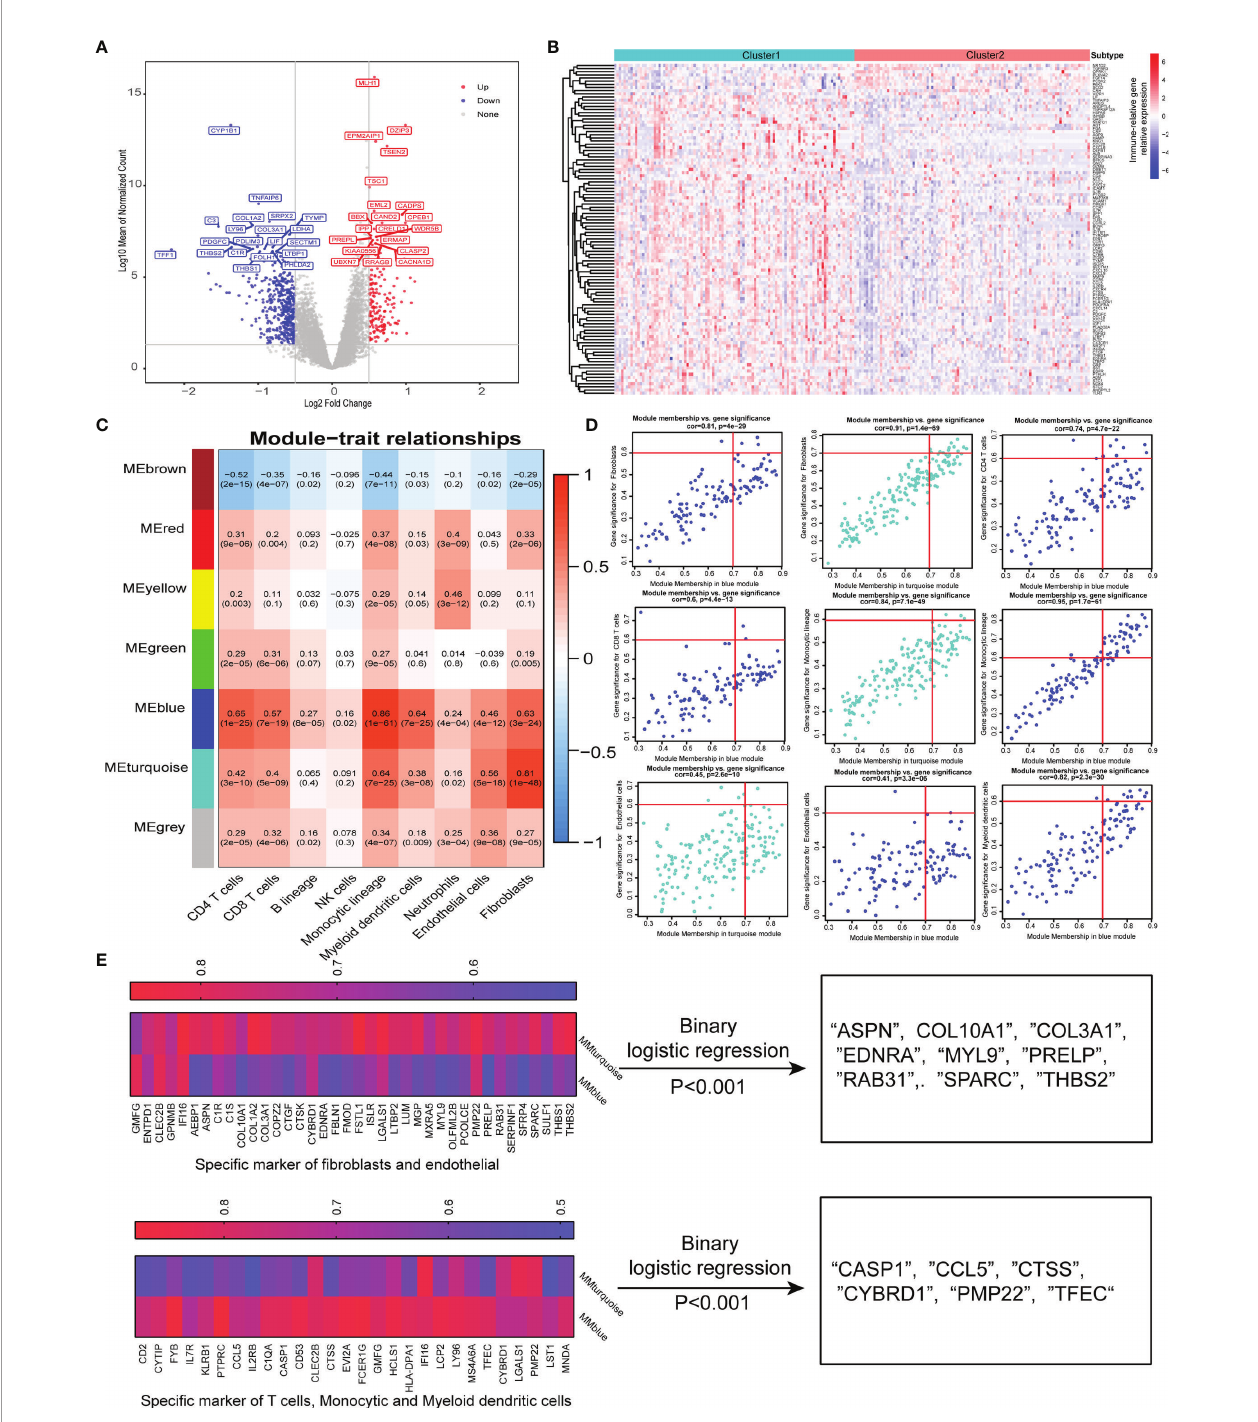
FIGURE 3 | Identi fi cation of speci fi c gene signature correlated with immune and stromal cells. (A) Differentially expressed genes between two-pathway-related molecule patterns. The expression of top 20 (red) and 20 (blue) upregulated genes in cluster 1 (blue) and cluster 2 (red). (B) Immune-related genes upregulated and downregulated in cluster 2. (C) Correlation between the traits and gene modules, including fractions of immune or stroma cell calculated by MCP-Counter. Correlation coef fi cients and P values are shown in each cell. The dendrogram on the left presents the degree of difference between the modules. (D) Genes with MM.cor > 0.7 and GS.cor > 0.6 were considered as speci fi c markers for CAF and immune cells in turquoise and blue modules. (E) Canonical markers in turquoise and blue modules based on MM.cor and GS.cor calculated by WGCNA (left). The speci fi c cell-related markers were screened by binary logistic regression